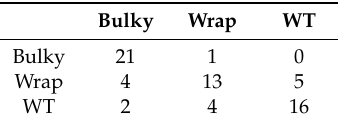
Table 3. Confusion table for the test set. Each row indicates different true labels, and each column indicates different predictions. In the test set, the accuracies are 0.9545 (Bulky), 0.5909 (Wrap), and 0.7273 (WT).